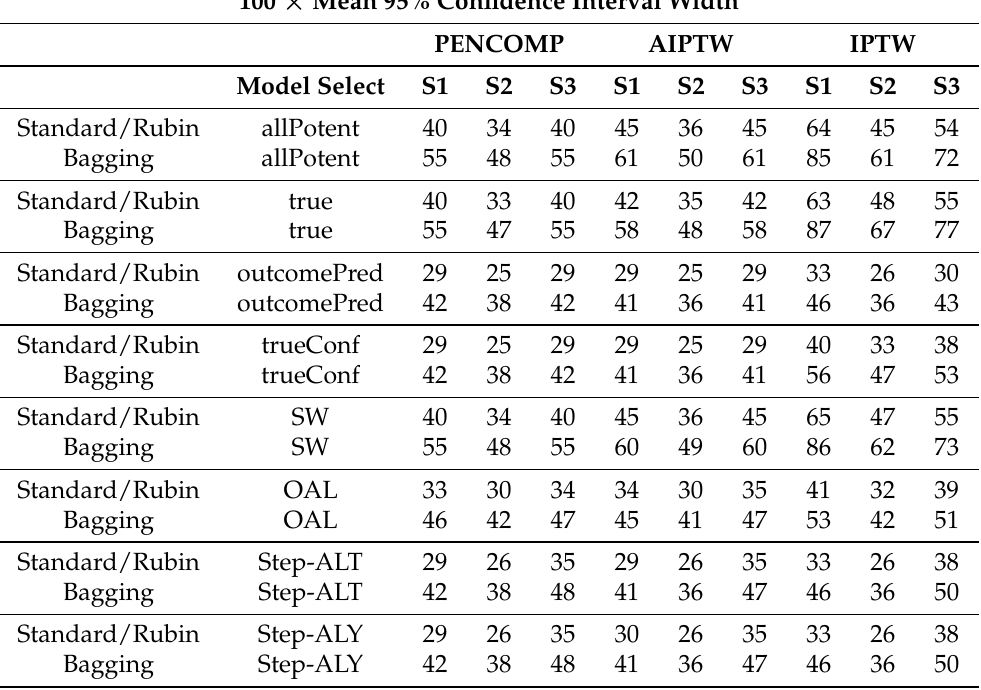
Table A4. 100 × mean 95% confidence interval width with sample size of 1000. The treatment effects η = 2. S1, S2, and S3 denote scenario 1, 2, and 3,